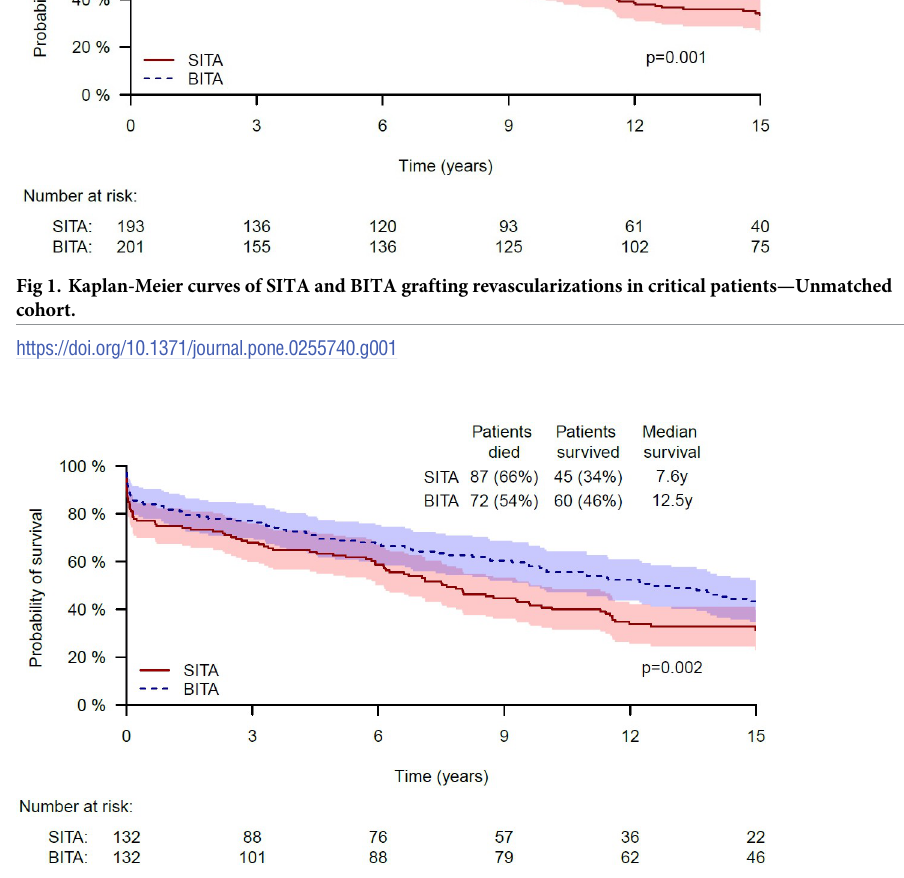
Fig 2. Kaplan-Meier curves of SITA and BITA grafting revascularizations in critical patients—Unmatched